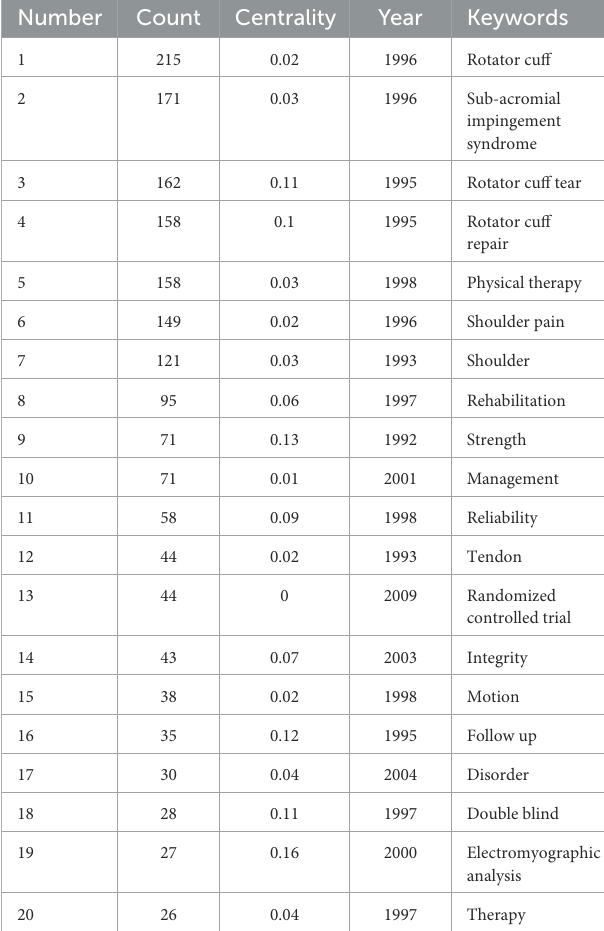
TABLE 6 The top 20 most frequently used